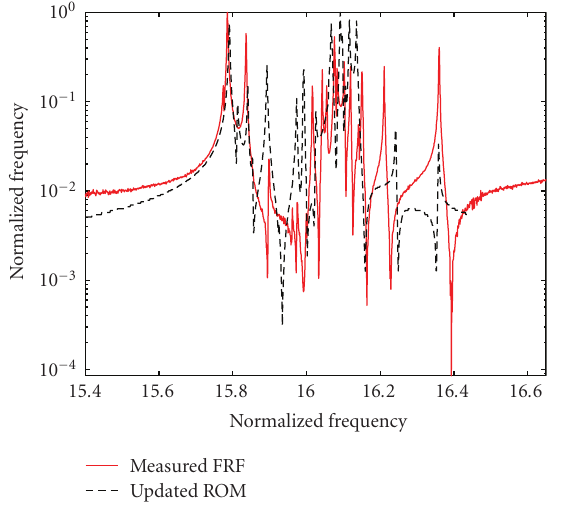
Figure 12: Forced response